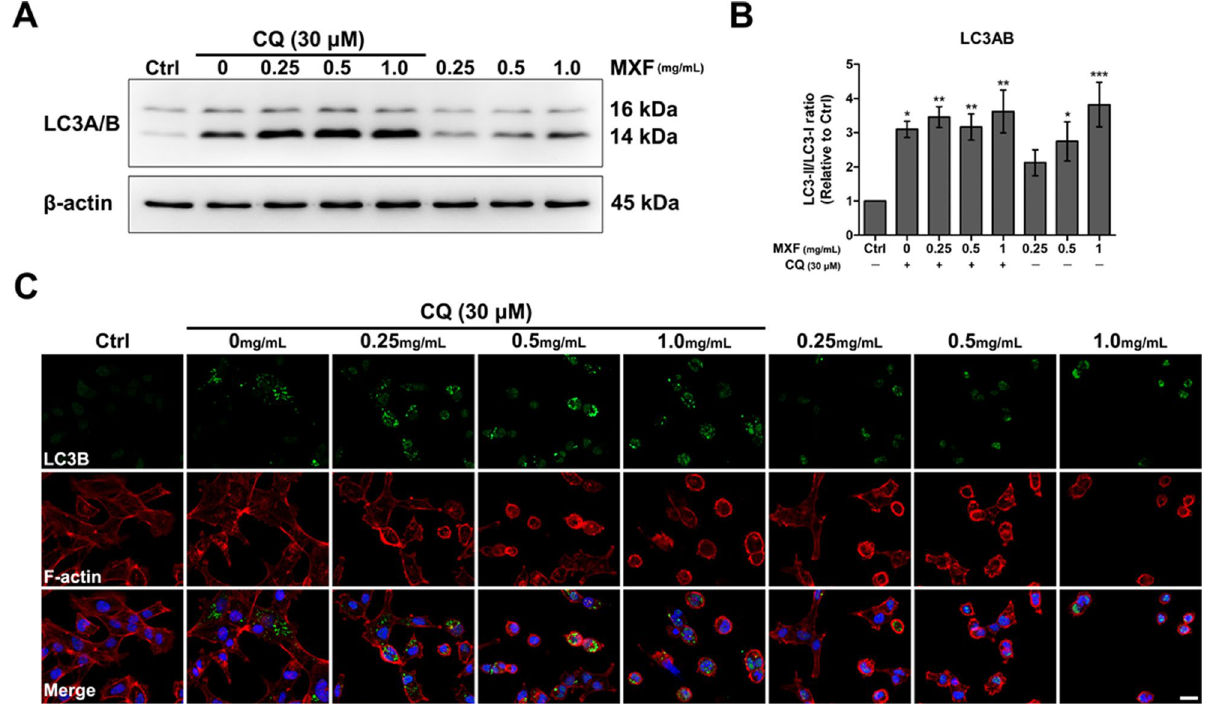
Figure 3. The effect of MXF on the autophagy of HCECs. MXF exposure induced a dose-dependent increase of autophagy in HCECs. LC3A/B I form (16 kDa) is converted to LC3A/B II form (14 kDa) with the activation of autophagy. As shown in ( A ) and ( B ), increased autophagy was observed after exposure to MXF. Addition of chloroquine further enhanced the LC3A/B II form formation indicating the true enhancement of autophagy by MXF. Note that only the bands at the adequate molecular weights were shown here. Full length gel and blots are included in the supplementary information. LC3B immunostaining ( C ) also verified the increased autophagy after MXF exposure. The green fluorescence (LC3B) was increased with the treatment of MXF and was further enhanced with the addition of chloroquine (30 μM). Full length electrophoresis gel image is available in supplementary files. Data shown are the representatives of three independent experiments. CQ: chloroquine, Ctrl: no treated normal control. * p < 0.05; ** p < 0.01; *** p < 0.001. Scale bar: 20